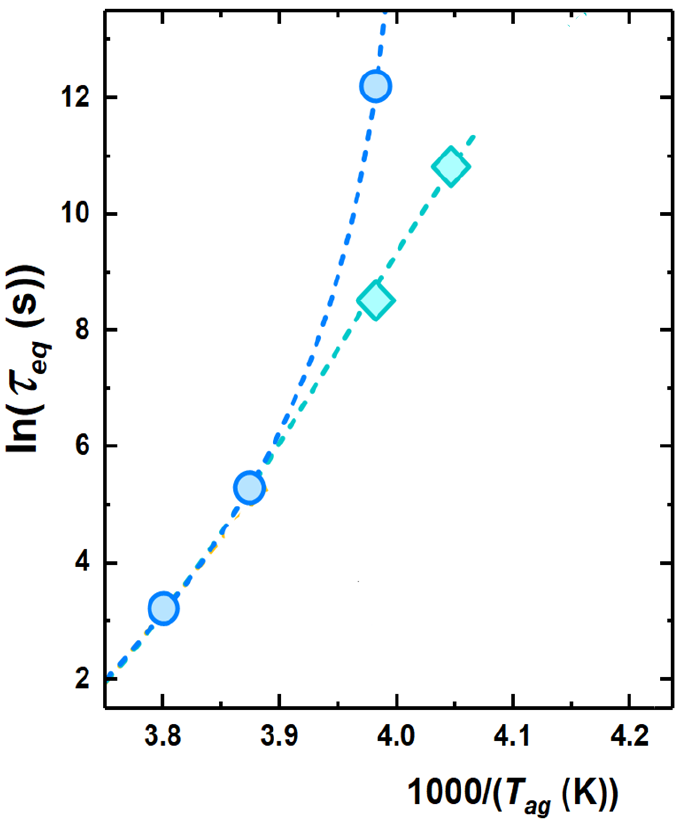
Figure 6. Activation plot showing the temperature evolution of the two time scales to reach